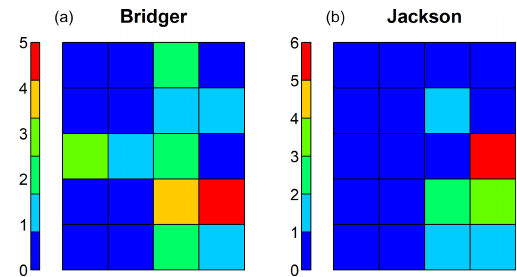
Figure 7. Counts for each synoptic type within the 72h prior to deep wet slab avalanches at Bridger Bowl (a) and in the Jackson area (b)